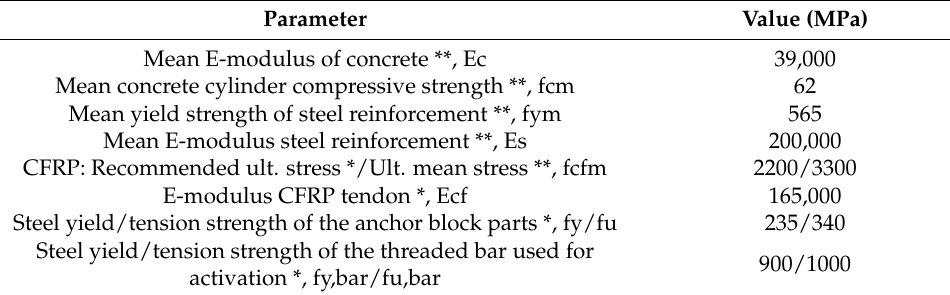
Table 2. Material properties related to the beam and end-anchor parts.